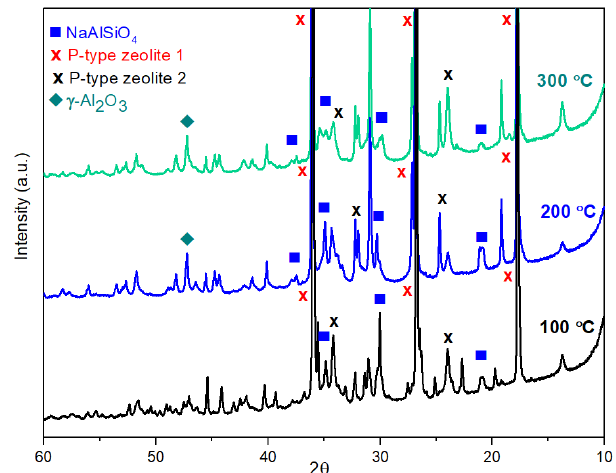
Figure 3. X-ray powder diffraction spectra of synthetic geopolymer samples heat-treated at 100 °C, 200 °C, and 300 °C.